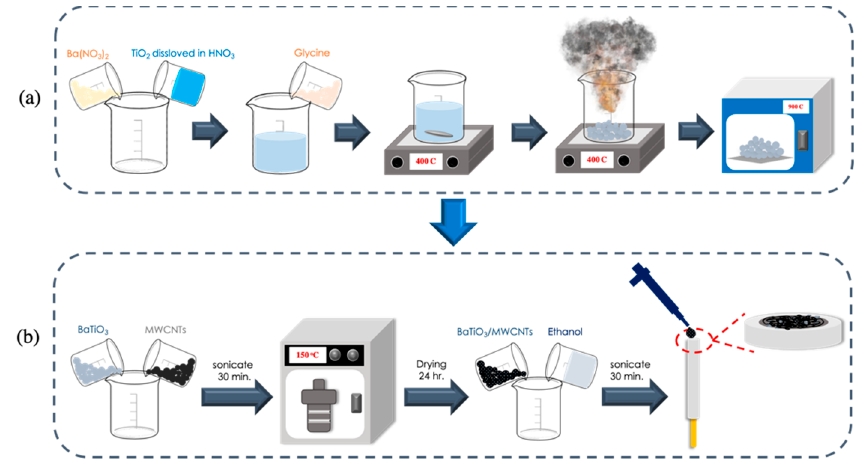
Figure 11. Schematized procedures for synthesizing the ( a ) BaTiO 3 powder using the solution combustion method and ( b ) BaTiO 3 /MWCNT composite-based electrode.